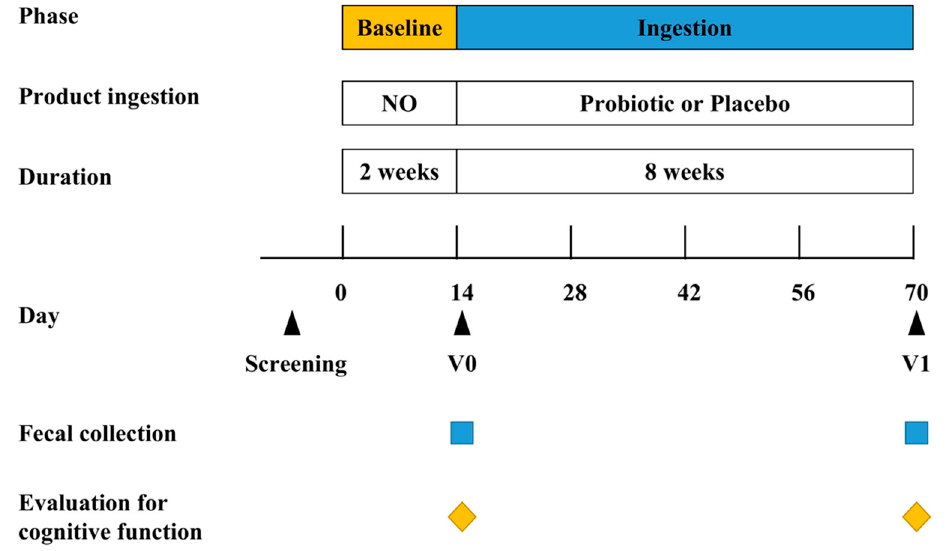
Figure 1. Study design. Probiotic: lyophilized powder containing B. longum BB68S. Placebo: maltodextrin. V0–V1: visit 0–visit 1.